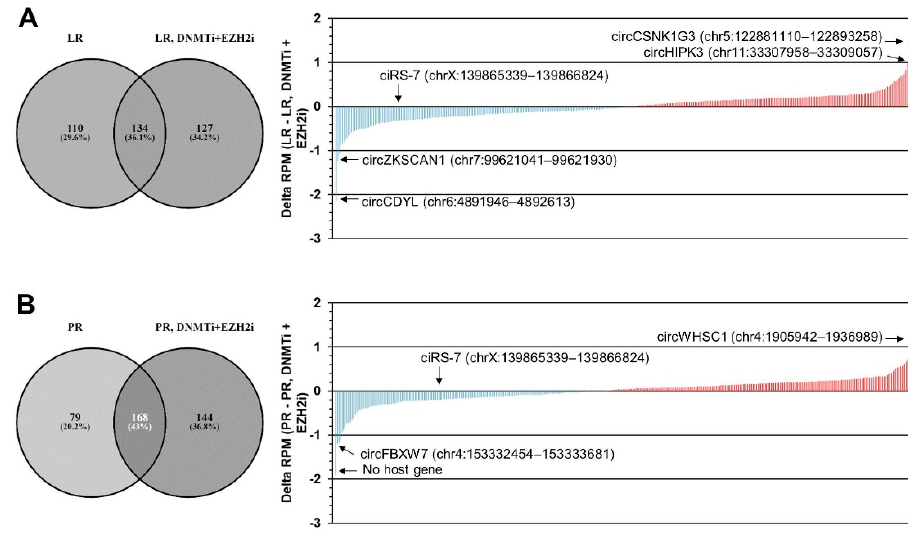
Figure 3. circRNA expression changes upon combined DNMT and EZH2 inhibition. ( A , B ) Waterfall plots illustrating the upregulated (in red) and downregulated (in blue) circRNAs in LR cells treated with DNMTi and EZH2i ( A ) and PR cells treated with DNMTi and EZH2i ( B ) relative to LR cells and PR cells, respectively. CircRNAs defined as high abundance in either LR cells, LR cells treated with DNMTi and EZH2i, PR cells, or PR cells treated with DNMTi and EZH2i, as shown in the Venn diagrams (left), were included in the analysis. ( C , D ) Scatter plots of log2 fold change in circRNA expression and log2 fold change in host gene expression in LR cells treated with DNMTi and EZH2i ( C ) and PR cells treated with DNMTi and EZH2i ( D ) compared to LR cells and PR cells, respectively. Potential correlations were assessed by calculating Pearson correlation coefficients, R 2 . LR, lenalidomide-resistant, PR, pomalidomide-resistant. There was no tendency for circRNAs to be upregulated in both LR and PR cells treated with epi-drugs nor for circRNAs to be downregulated in both LR and PR cells treated with epi-drugs (Supplementary Figure S4B,C). Likewise, there was no significant overall increase or decrease in circRNA abundance upon treatment with epi-drugs in these cell lines (Supplementary Figure S4D). 2.4. Validation of circRNA Candidates from the RNA-Seq Data by NanoString nCounter Technology Because ciRS-7 was the most downregulated circRNA in both LR and PR cells, and be- cause circIKZF3 was upregulated in both LR and PR cells, we decided to validate the pattern of down- or up-regulation of these two circRNAs by NanoString nCounter ®technology, which has been described as a sensitive and quantitatively accurate methodology [39,40]. We did indeed observe the same pattern of downregulation of ciRS-7 (Figure 4A) and upregulation of circIKZF3 (Figure 4B) in resistant cells. Interestingly, ciRS-7 was not found to be upregulated in the RNA-Seq data upon treatment with epi-drugs, contrary to the NanoString data (Figure 4A). We hypothesize that this discrepancy can be explained by the